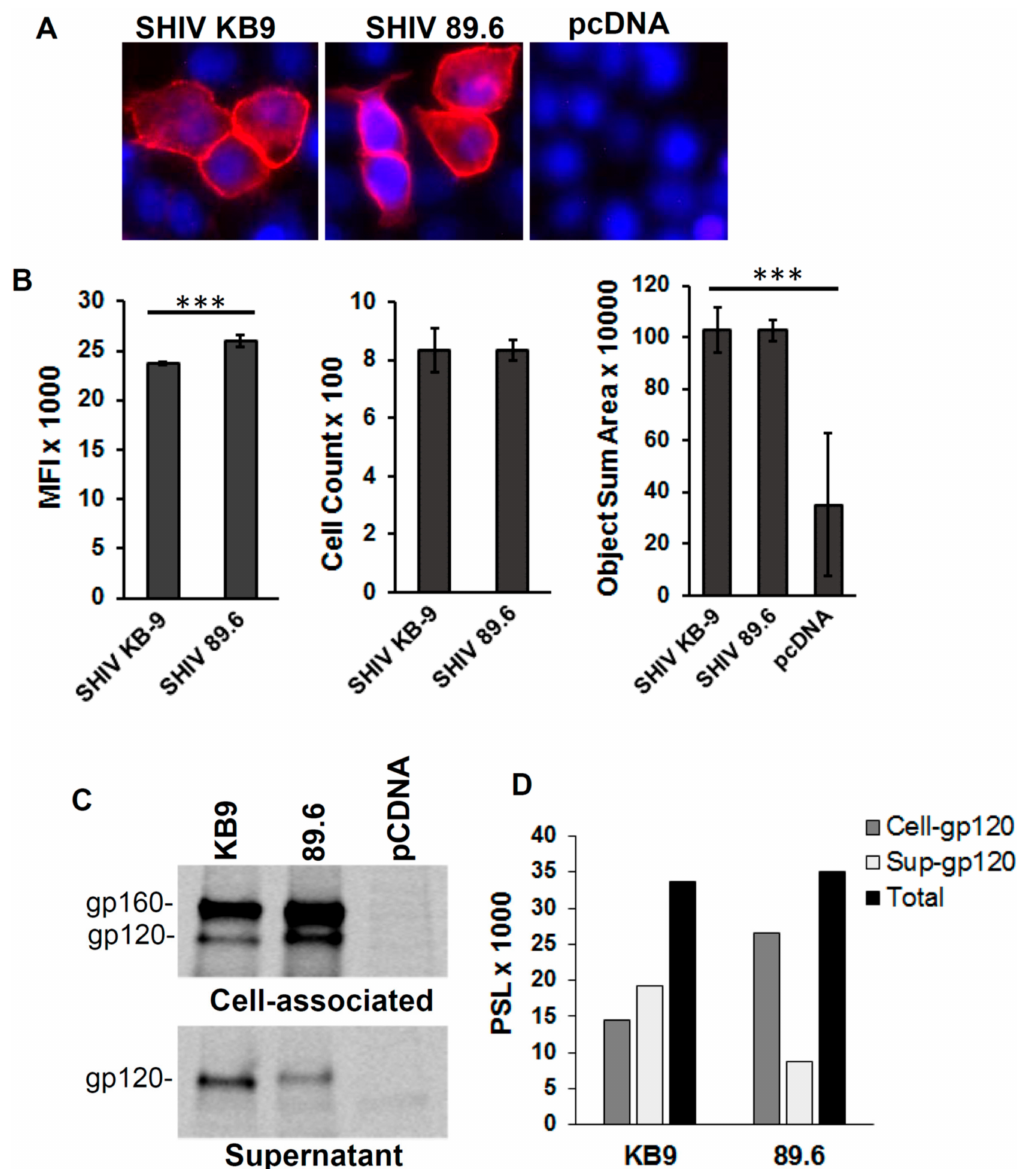
Figure 3. Env expression and Env shedding for KB9 and 89.6 Envs. HeLa cells were transfected with Env expression constructs for KB9, 89.6 or control pcDNA3.1 vector. Surface Env expression was determined 48 hrs post transfection after staining with the b12 antibody flowed by fluorescence microscopy ( A ). Whole wells of 96-well plate were scanned to determine MFI, positive cell counts and object sum area. p ≤ 0.0001 as determined by one-way ANOVA ( B ). HeLa cells were transfected as above and Env shedding was determined after radiolabeling of cells with [35S] Met / Cys followed by immunoprecipitation of cell lysates and supernatants using HIV Ig ( C ). Quantitation of cell associated and shed gp120 ( D ). One representative of two independent experiments is